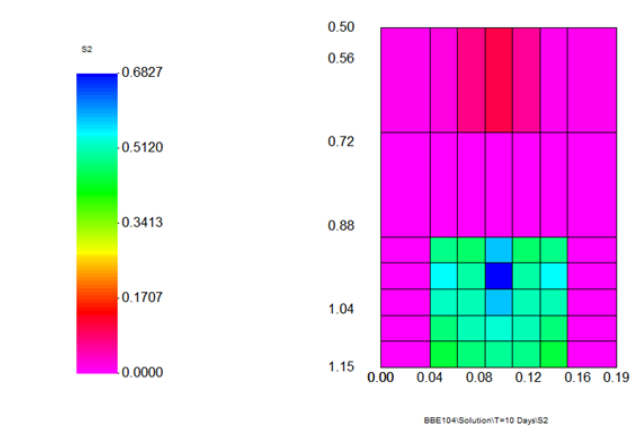
Figure 8: Oil saturation distribution after 10 days of imbibition. The vertical XZ cross section through the center (at Y-slice=4) of the